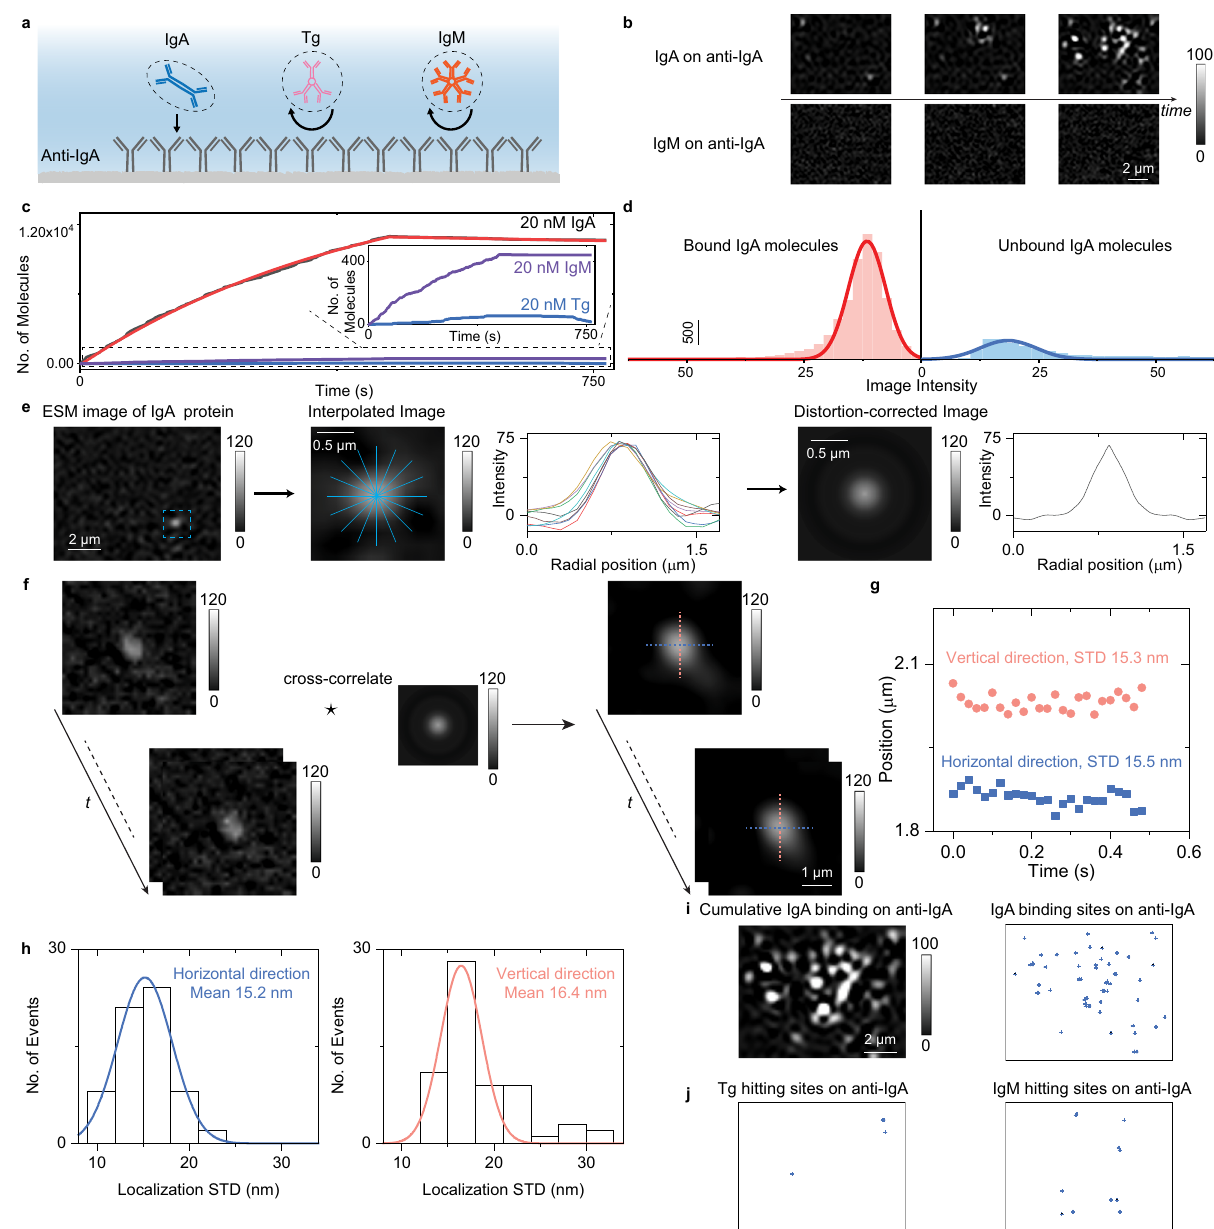
Fig. 3 ESM identi fi cation of single proteins using antibodies. a Schematic showing the behaviors of single IgA, Tg, and IgM proteins on the anti-IgA